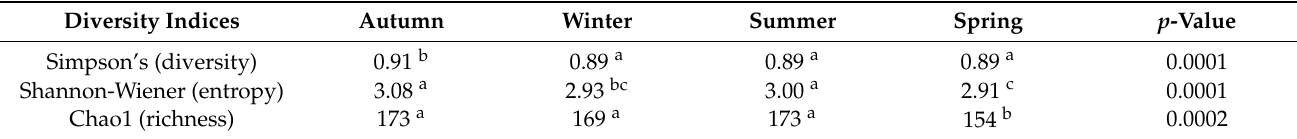
Table 5. Comparison of the median alpha diversity indices between seasons.